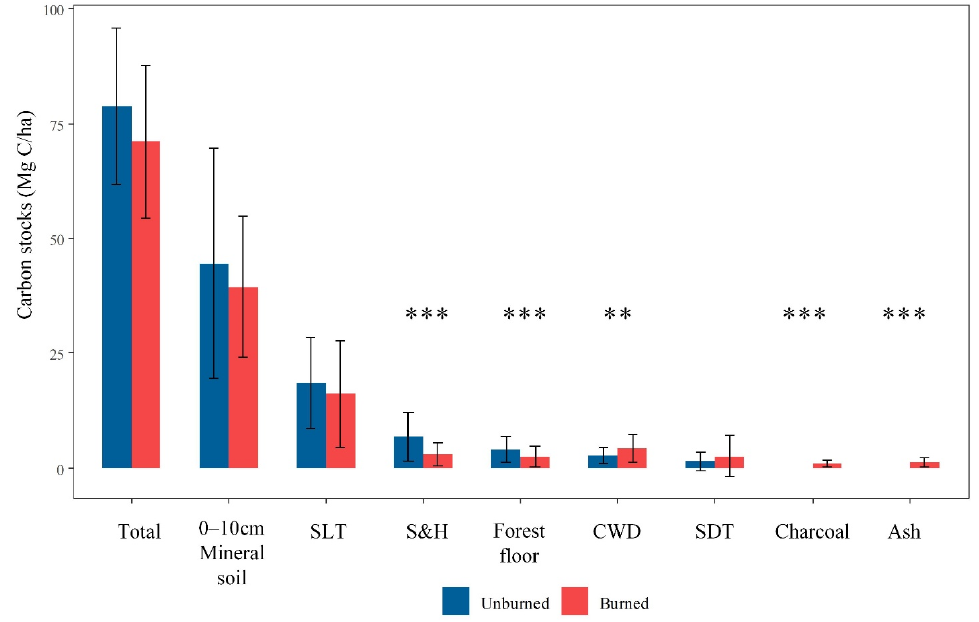
Figure 2. Stocks of various carbon pools in the unburned and burned plots (Mg C/ha). (SLD: stand- ing live trees, S&H: shrubs and herbaceous vegetation, forest floor: litter and duff, CWD: coarse woody debris, and SDT: standing dead trees. p < 0.05 **, p < 0.01 ***).